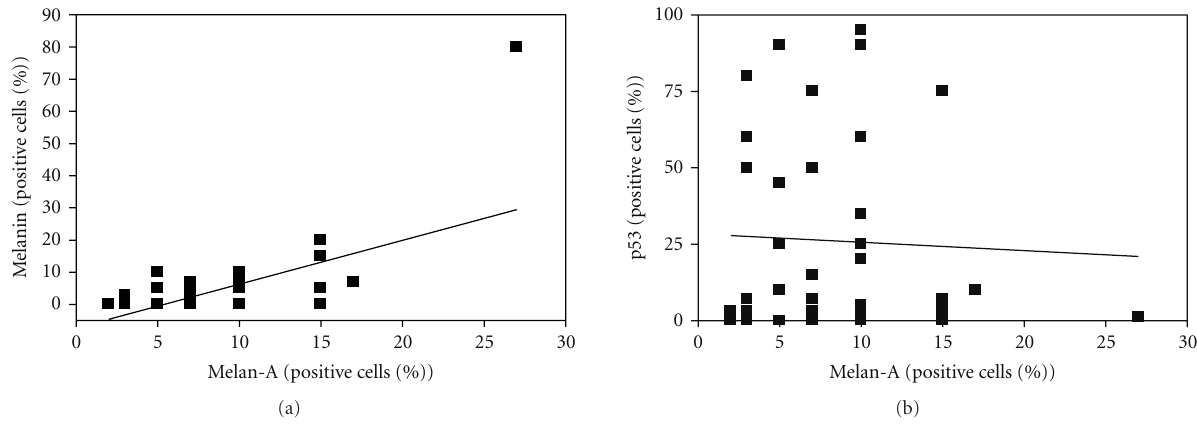
Figure 1: Correlation of pigmentation with melanocyte colonization (a) and lack of correlation between p53 positivity and melanocyte colonization. (b) 49 BCC tissue sections were analyzed immunohistochemically for the presence of melanin, the expression of the melanocyte marker melan-A and p53 expression. The frequency of melanin- and p53-positive tumor cells as well as the frequency of melan-A-expressing melanocytes was scored. (a) The correlation between melanocytes and pigmentation was statistically significant ( P < . 0001). (b) There was no correlation between the frequency of melanocytes and p53 expression ( P = . 77).